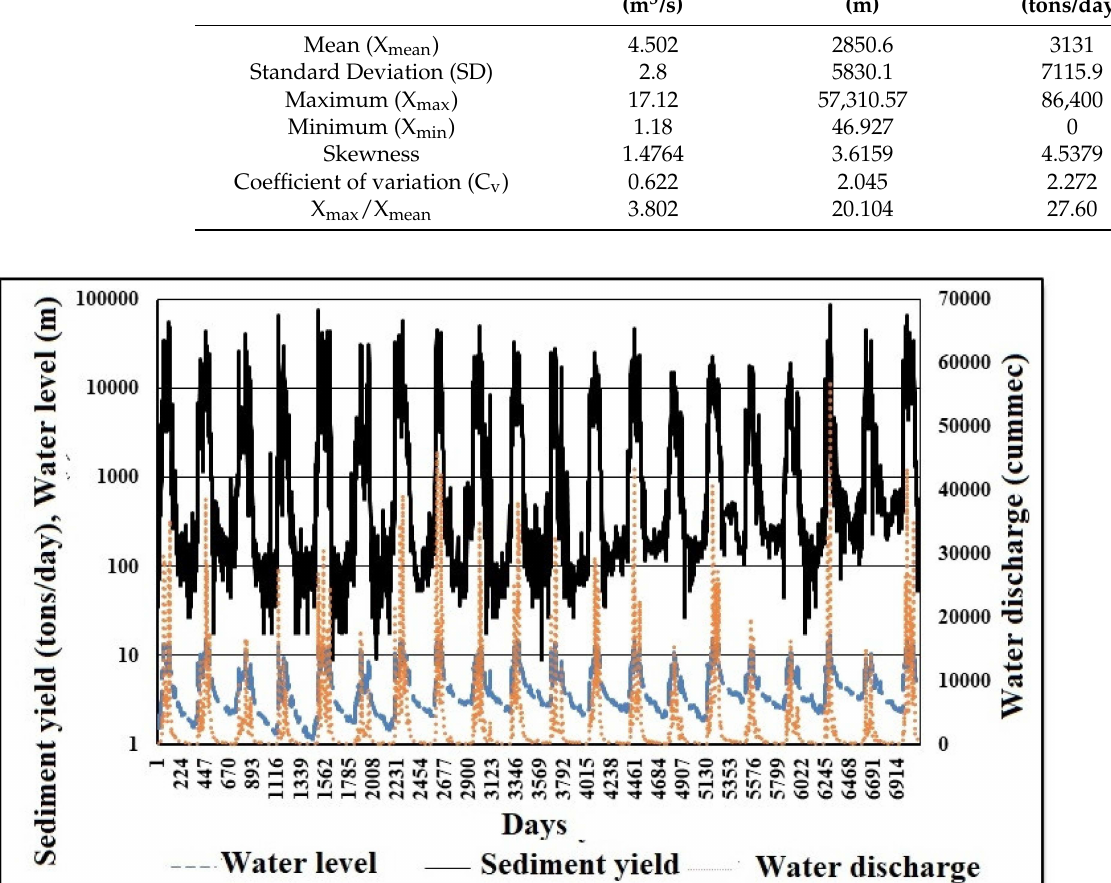
Figure 3. Variations in daily mean of hydro climatic data: SSY (tons/day), WL (m) and WD (cummec) at the Polavaram in Godavari River